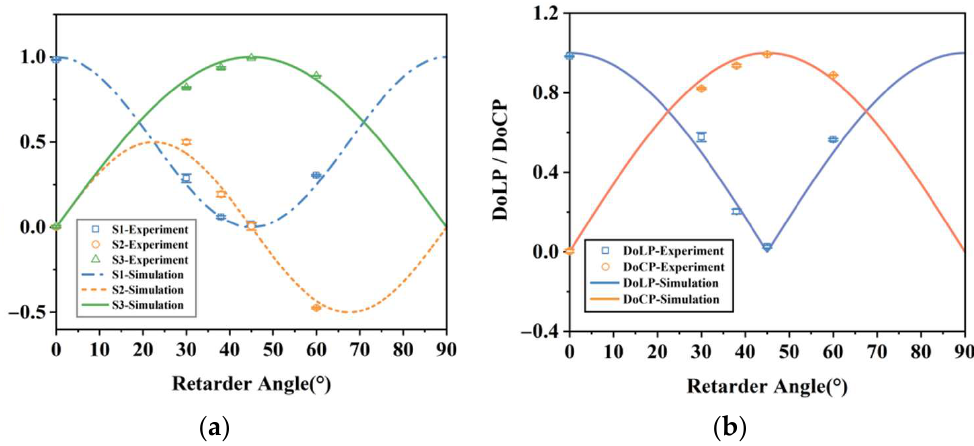
Figure 11. Plots of ( a ) the experimental and simulation values of S 1 , S 2 , S 3 , and ( b ) DoLP and DoCP parameters as a function of the fast axis orientation of QWP1 at 632.8 nm measured by the full Stokes polarization detection method.